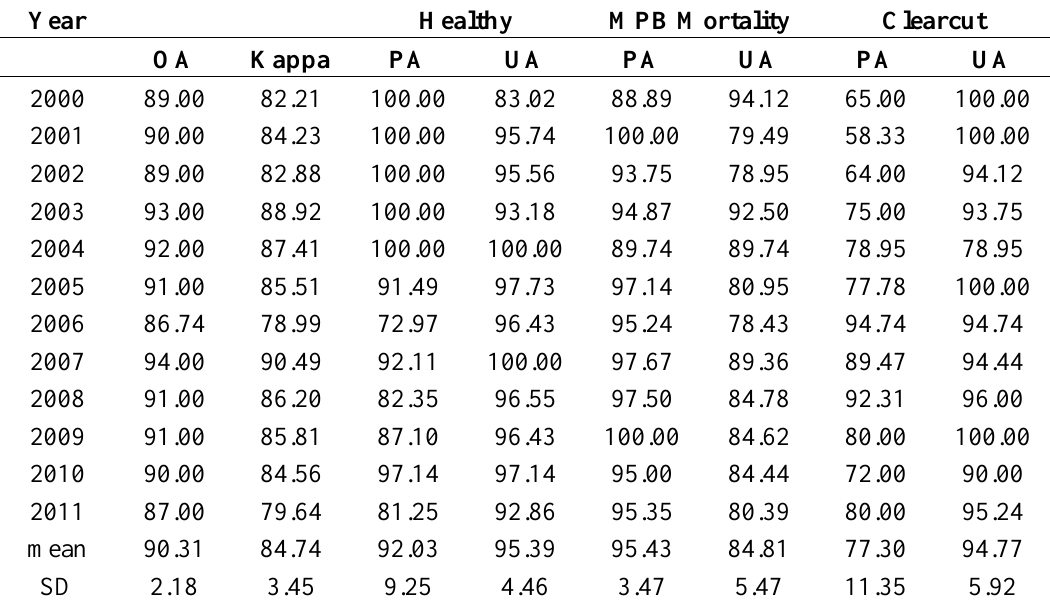
Table 6. Accuracy assessment results for individual years of the time series classification.